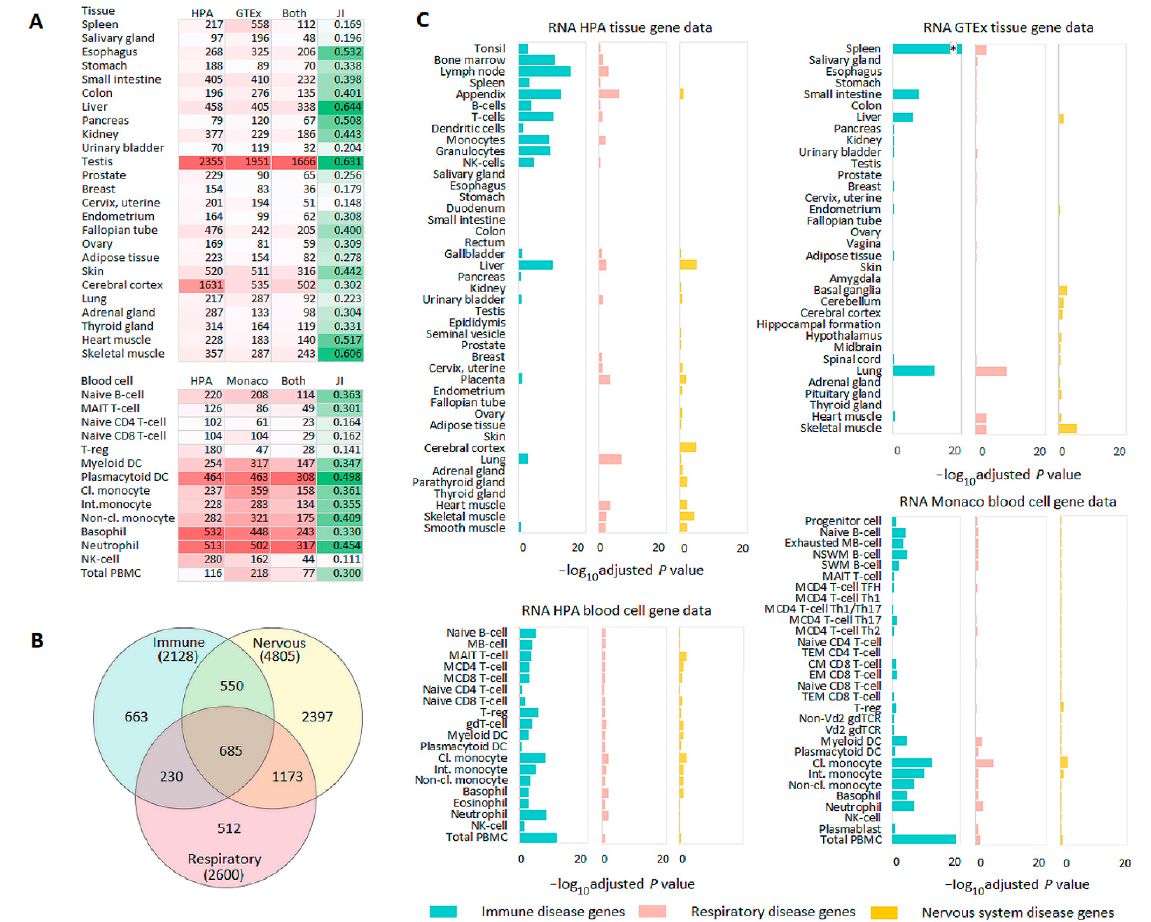
Figure 2. Tissue- and blood cell-specific gene enrichment analysis. ( A ) Heatmap with the number of genes (colored in red) enriched in the same tissues (HPA and GTEx) or blood cells (HPA and Monaco). Enriched genes include genes relating to all categories of enrichment in a corresponding tissue (tissue enriched, group enriched, and tissue enhanced). Jaccard index (JI) (colored in green) shows tissue or blood cell similarity determined by gene enrichment analysis with TissueEnrich. ( B ) Venn diagram showing an overlap among immune, respiratory, and nervous system disease genes. ( C ) TissueEnrich results for immune, respiratory, and nervous system disease genes. Abbreviations: Cl., Classical (monocyte); CM, Central memory (CD8 T-cell); EM, Effector memory (CD8 T-cell); Int., Intermediate (monocyte); M, Memory (MB-cell, MCD4 T-cell, MCD8 T-cell); Non-cl., Non-classical (monocyte); NSWM, Non-switched memory (B-cell); SWM, Switched memory (B-cell); TEM, Terminal effector memory (CD4, CD8 cells); * − log 10 adjusted p value = 43.22.